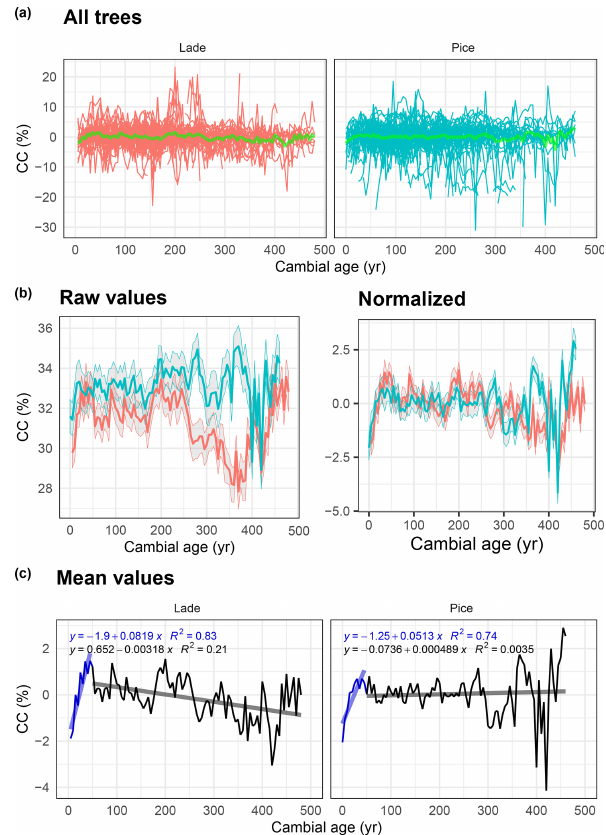
Figure 7. Analysis of cellulose content (CC) data: (a) raw value of all larch (LADE, red) and cembran pine (PICE, green) trees; the green line corresponds to the mean. (b) Raw (left) and normal- ized (right) mean value with corresponding ± 1 standard deviation (gray area) of larch (red) and cembran pine (cyan). (c) Plots of the mean values with linear approximations for the periods 1–50 and > 50